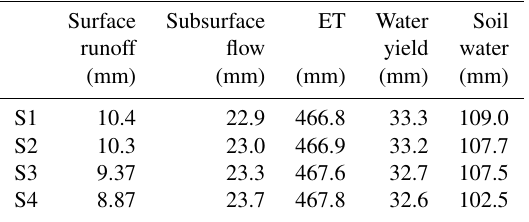
Table 6. Simulated average annual values of hydrological compo- nents under different scenarios of slope land